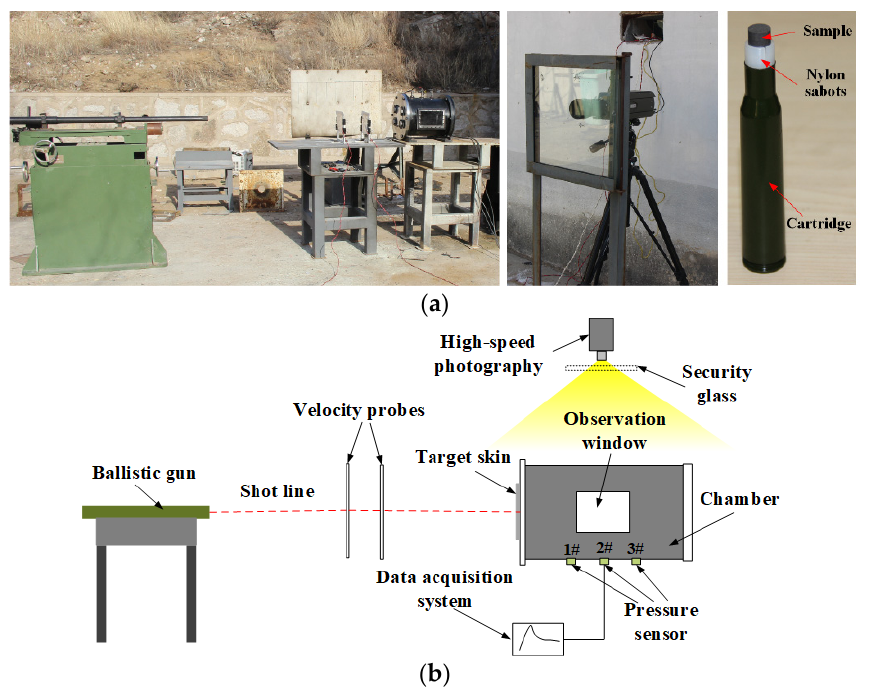
Figure 3. Experimental setup: ( a ) physical; ( b ) schematic.